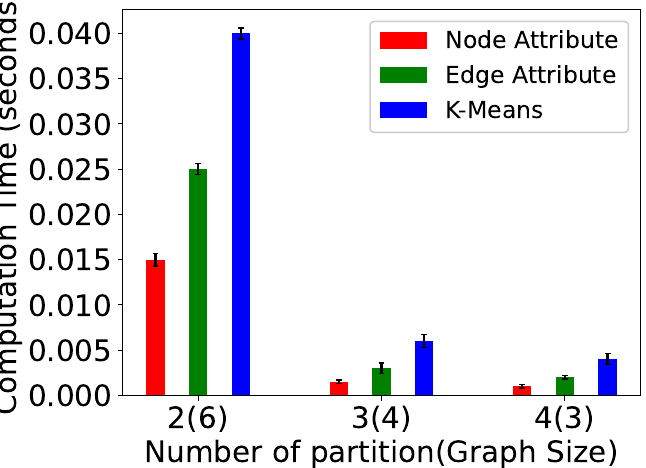
Figure 14. Computation time for P-TSP for a varied number of